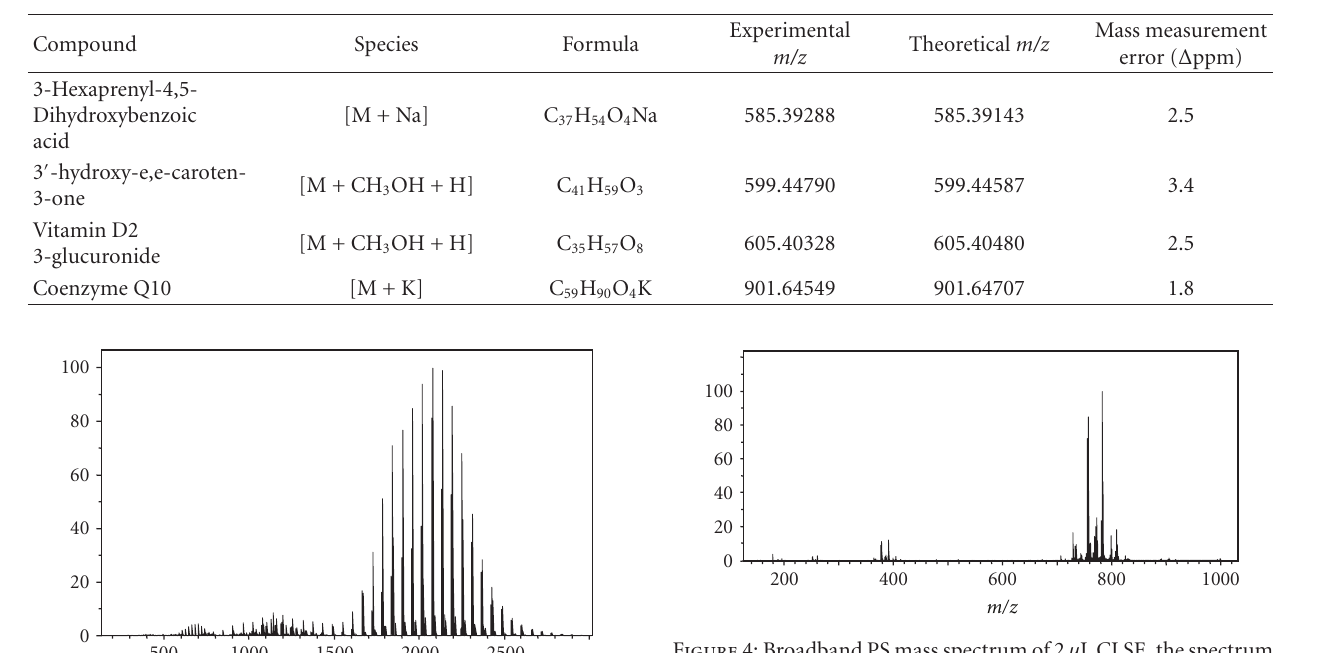
Table 4: Compounds identified using paper spray mass spectrometry on urine sample from 27-year-old volunteer. The urine mass spectrum was obtained with both an excitation and detection frequency range of 1.5MHz.